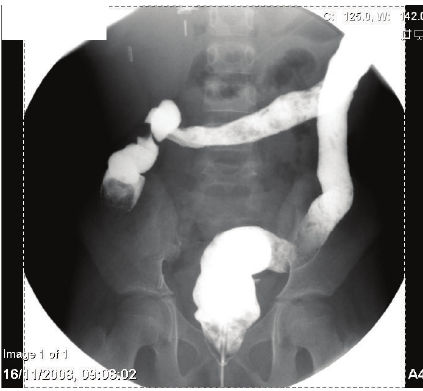
Figure 1: Gastrografin enema examination demonstrates loss of haustral folds in the colon with small ulcerations.